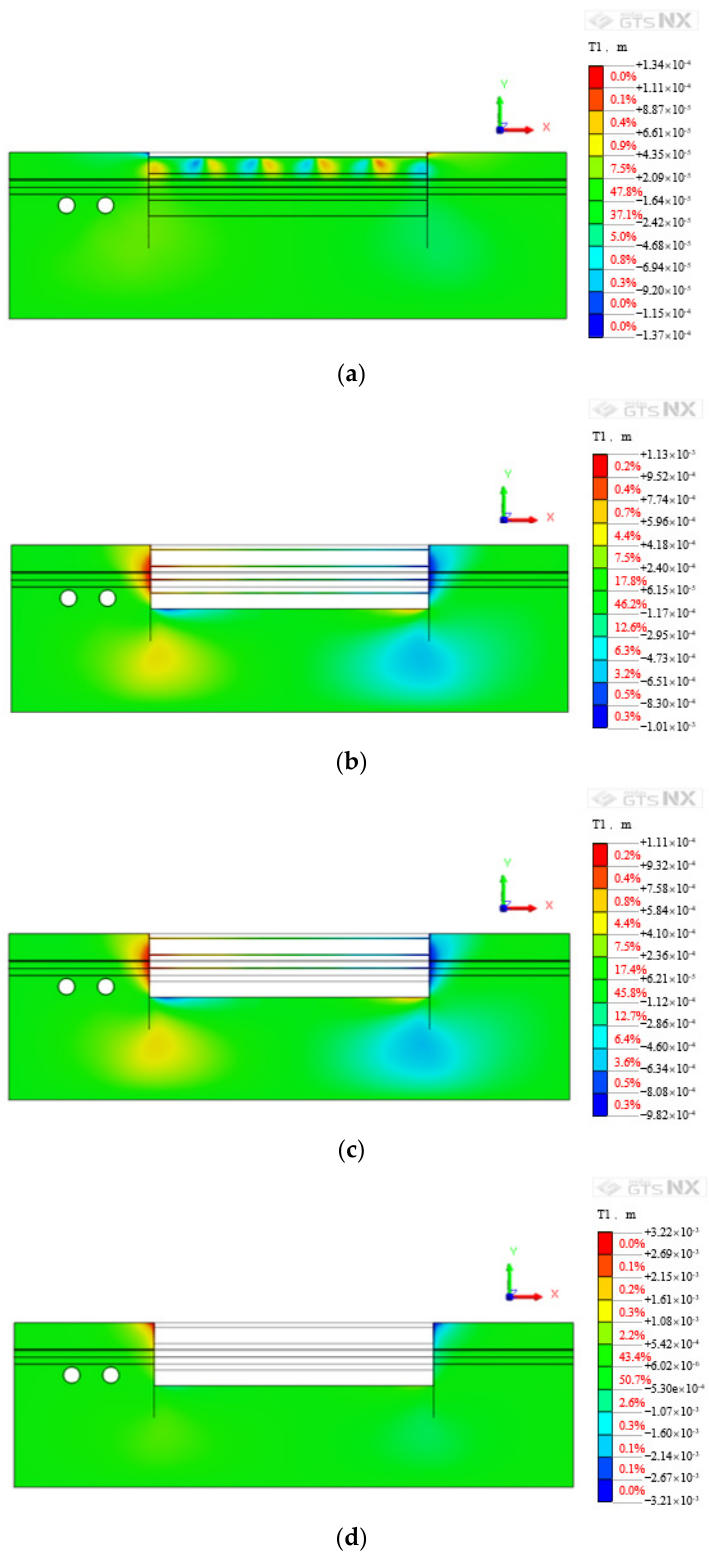
Figure 11. Horizontal deformation subway tunnel caused by construction of section A. ( a ) Excavate to − 2.20 m elevation. ( b ) Excavate to the design elevation of the bottom of the foundation pit. ( c ) The inner supports on the fourth layer are removed. ( d ) All inner supports are removed.